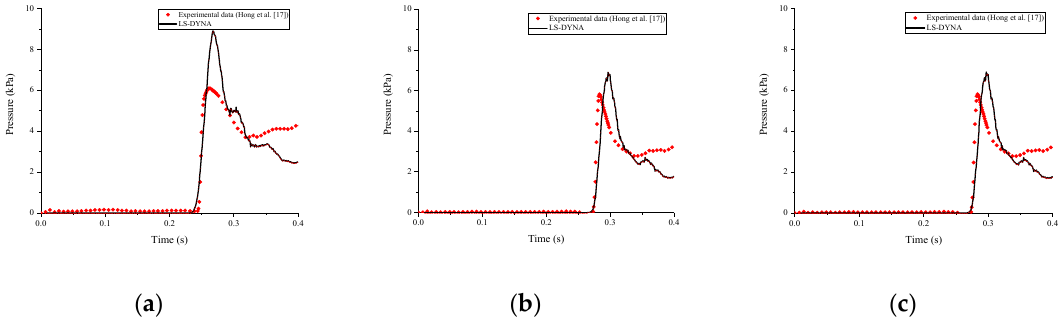
Figure 5. Comparison of the slamming pressure at each point between the numerical results and experimental data: ( a ) Pressure at P1; ( b ) pressure at P2; ( c ) pressure at P3.